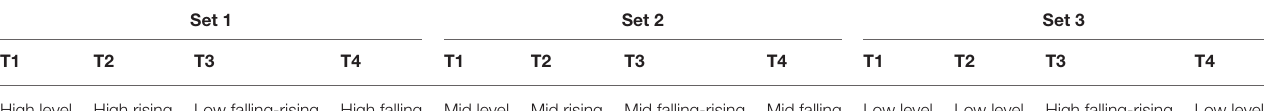
TABLE 2 | Description of